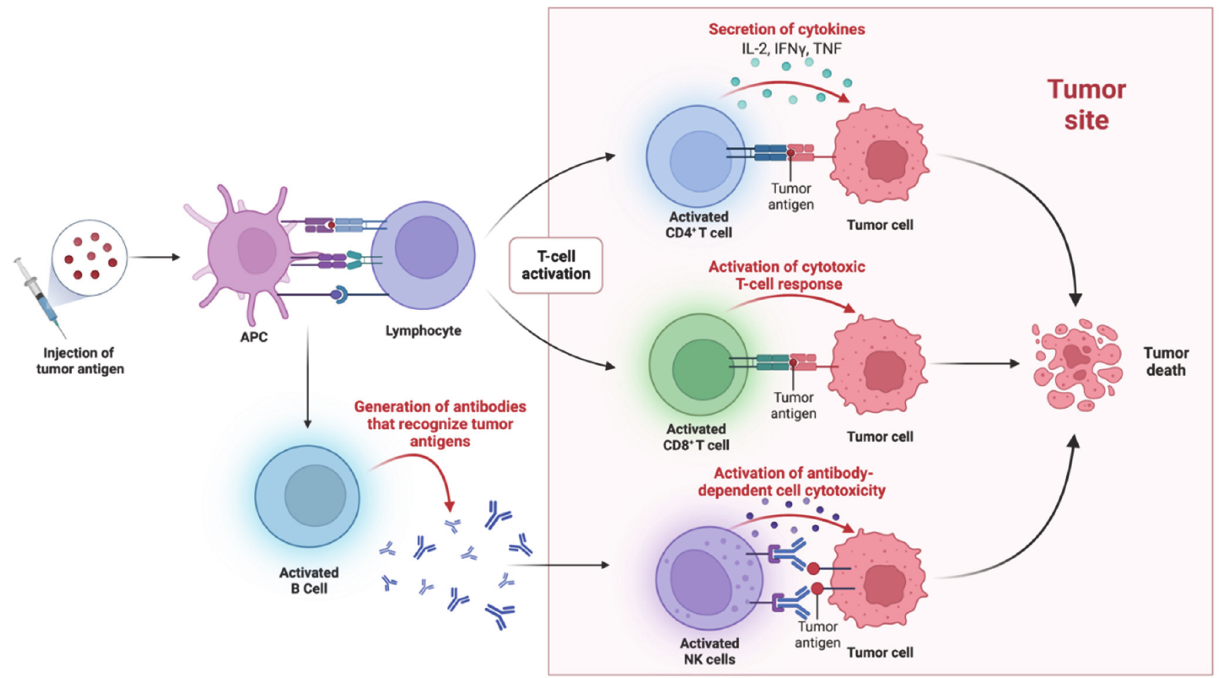
Figure 3. Cancer Vaccines Activate the Immune System to Target Tumor Cells. Cancer vaccines in- troduce tumor antigens (proteins found on the surface of cancer cells) into antigen-presenting cells (APCs), such as dendritic cells, which then activate CD8+, CD4+, and B cells to mount an immune response against cancer cells. CD8+ T cells, also known as cytotoxic T cells, are responsible for killing cancer cells directly. CD4+ T cells, also known as helper T cells, help activate and coordinate the immune response by releasing cytokines that a tt ract other immune cells to the site of the tumor. B cells, another type of immune cell, produce antibodies that can target cancer cells. Antibodies can bind to tumor antigens on the surface of cancer cells, marking them for destruction by other immune cells or activating complement proteins that lead to cell death.